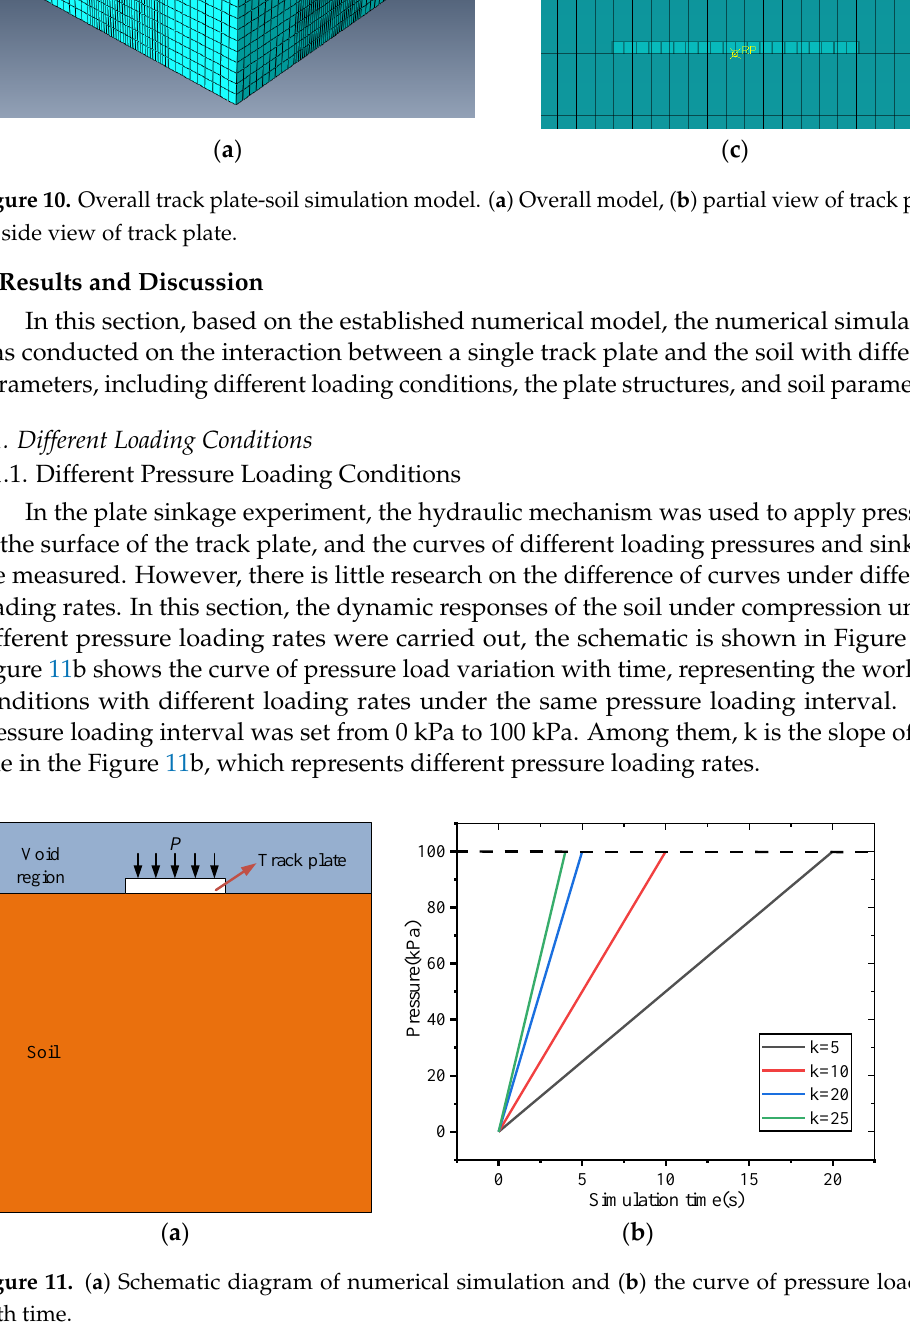
Figure 10. Overall track plate-soil simulation model. ( a ) Overall model, ( b ) partial view of track plate, ( c ) side view of track plate.